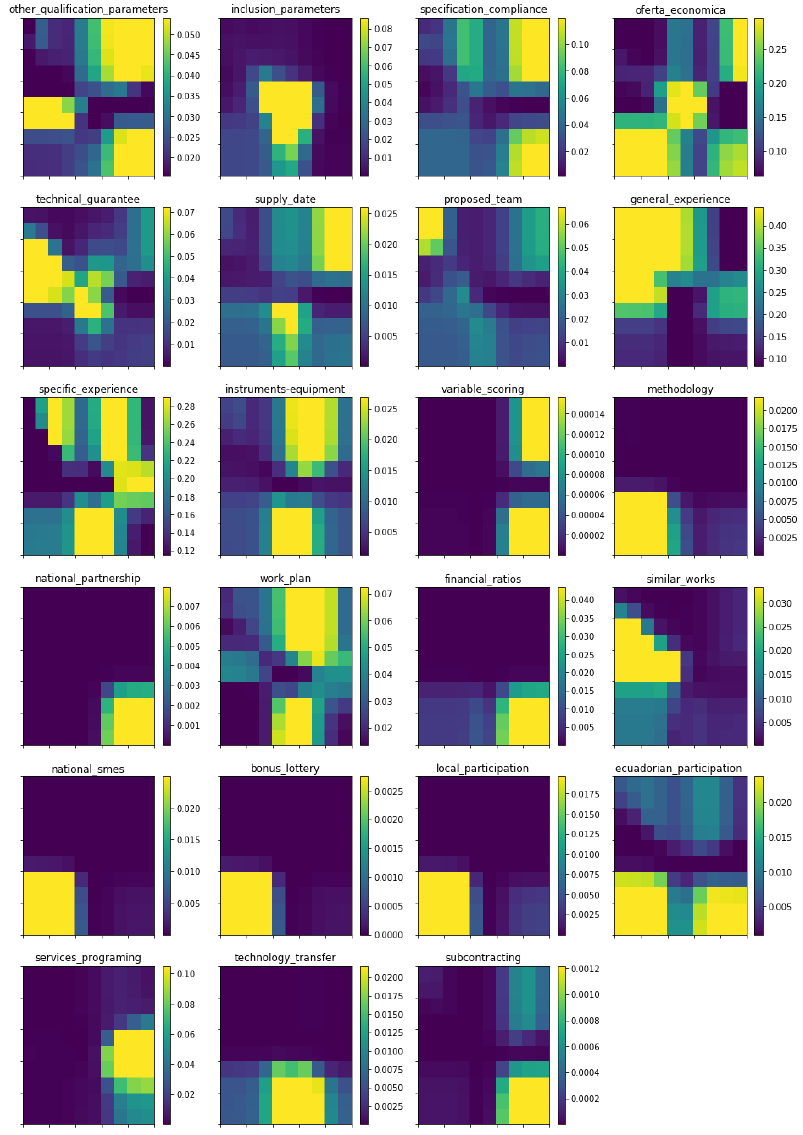
Figure 4. Evaluation of influence of qualification parameters with SOM. A heat map (Figure 5) shows the assignment of the processes to each cluster rep- resented in green, light blue, orange and red for each cluster, and the dark-blue values represent a small number of elements and are assigned to the nearest cluster. A colour scale from zero (withe) to 60,000 (dark green) represents the number of elements associated with the